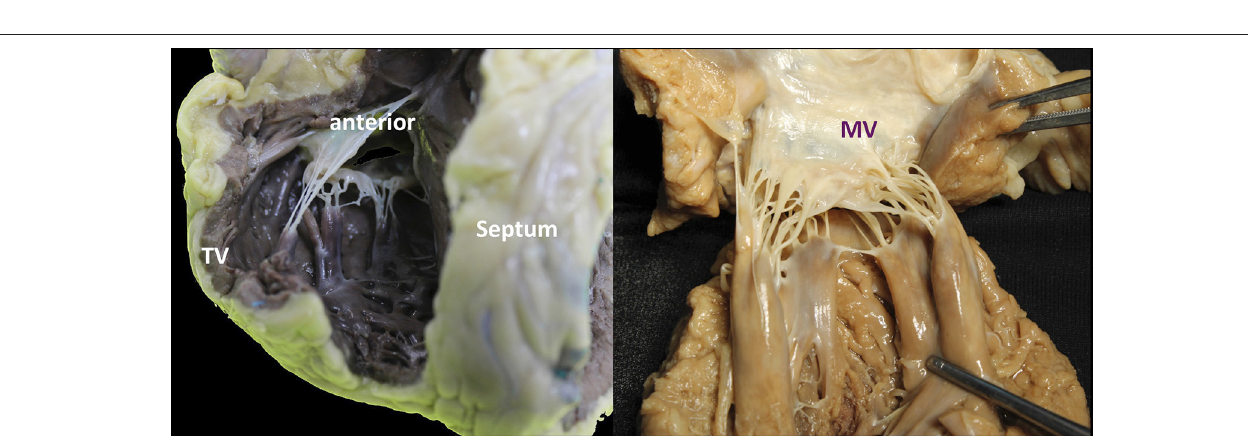
FIGURE 6 | Multimodality imaging of the TV. (A) Deep transgastric 2D TEE view, displaying the TV in short axis from the ventricular side. (B) Same en face view derived from MSCT angiography. (C) Short-axis atrial view of the TV on 3D TEE and during surgery (D) . Red asterisks are the commissures. AL, anterior leaflet; LV, left ventricle; PL, posterior leaflet; RV, right ventricle; SL, septal leaflet. This image has been adapted from Taramasso et al. ( 1).